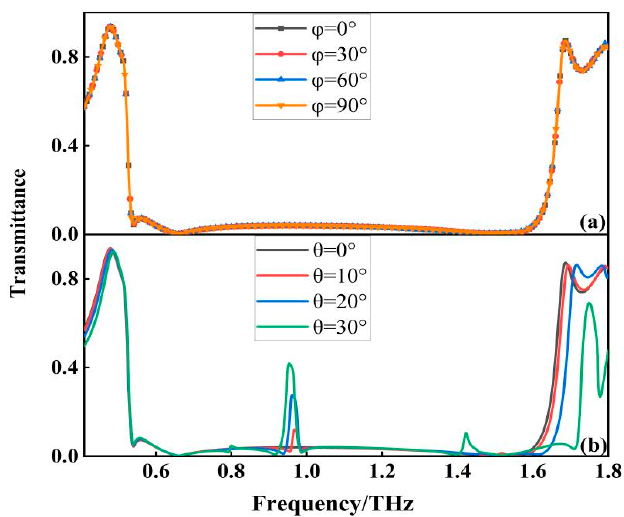
Figure 6. ( a ) Transmission curves corresponding to different polarization angles; and ( b ) Transmission curves corresponding to different incidence angles.